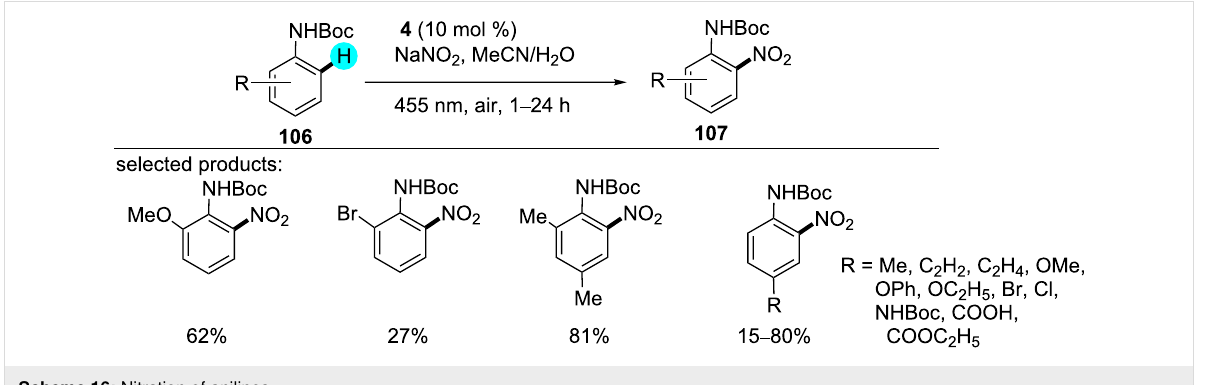
Scheme 16: Nitration of